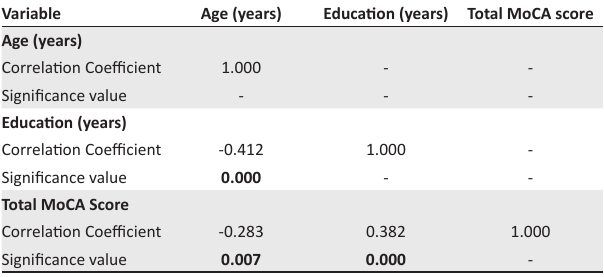
TABLE 2: Spearman correlations between age, years of education and total Montreal Cognitive Assessment